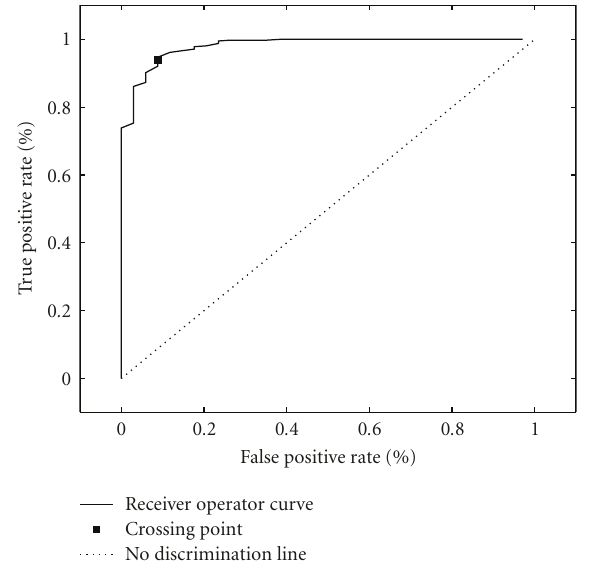
Figure 14: ROC for the “Two Correlations Case.”